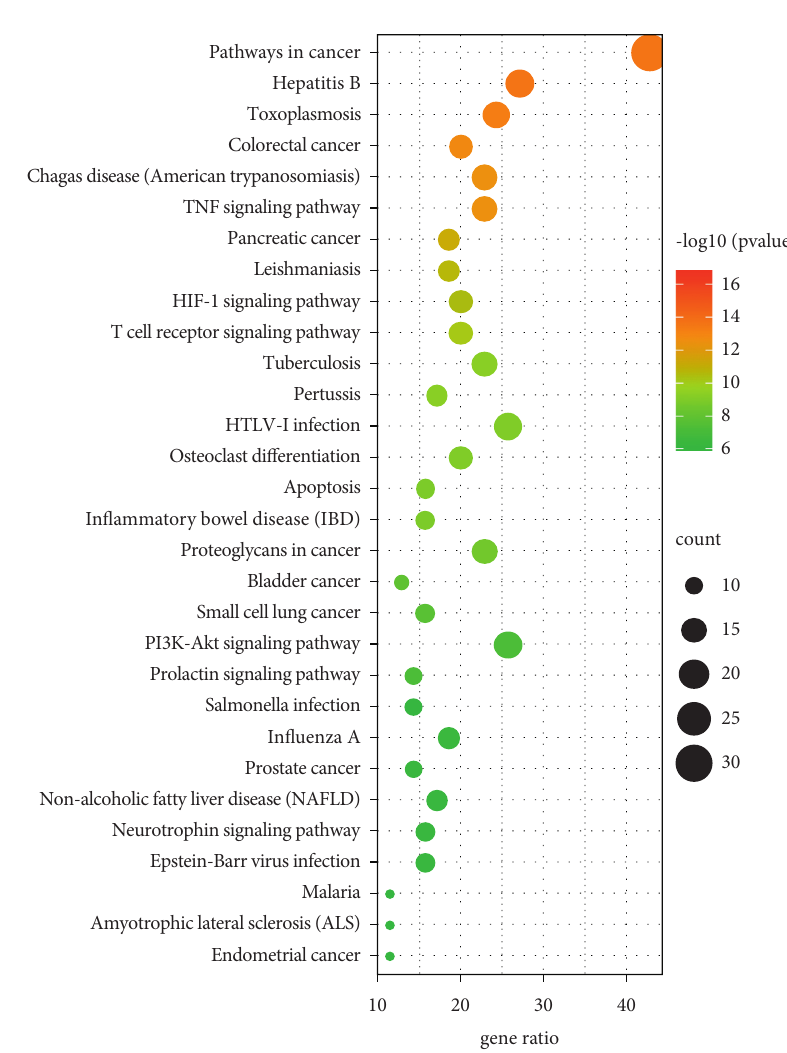
Figure 7: The KEGG pathway enrichment analysis of 149